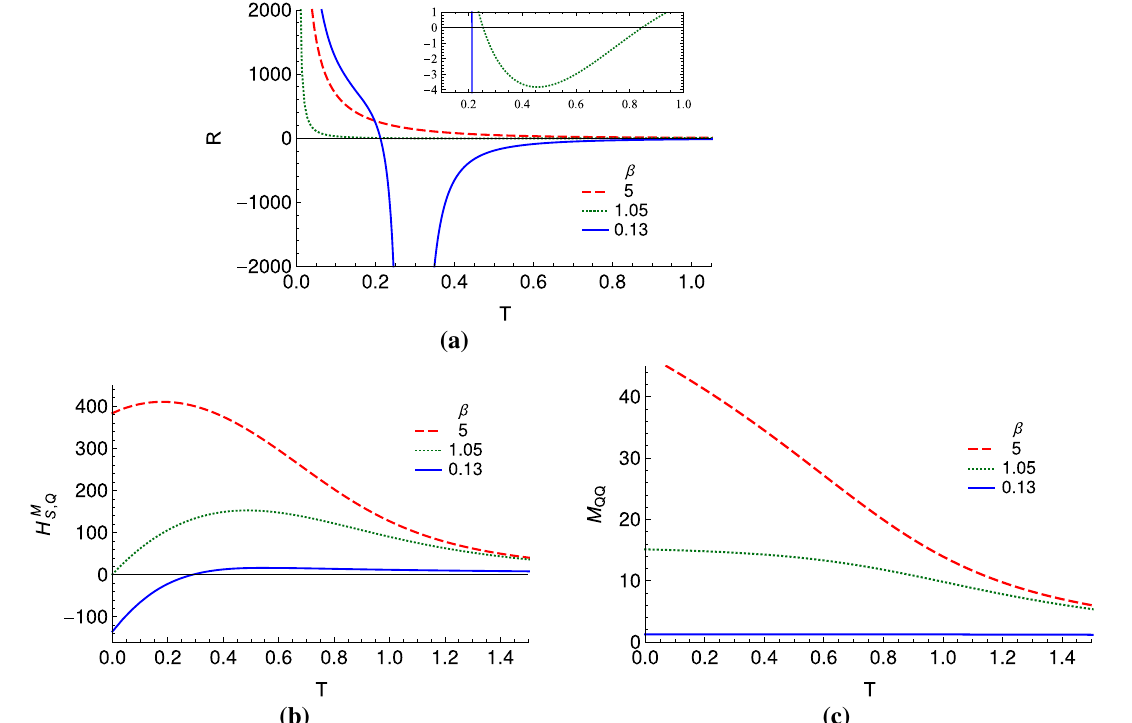
and M QQ versus T for the Born–Infeld case with b = 0 . 9, l = 0 . 76, n = 6, z = 3 and S , Q